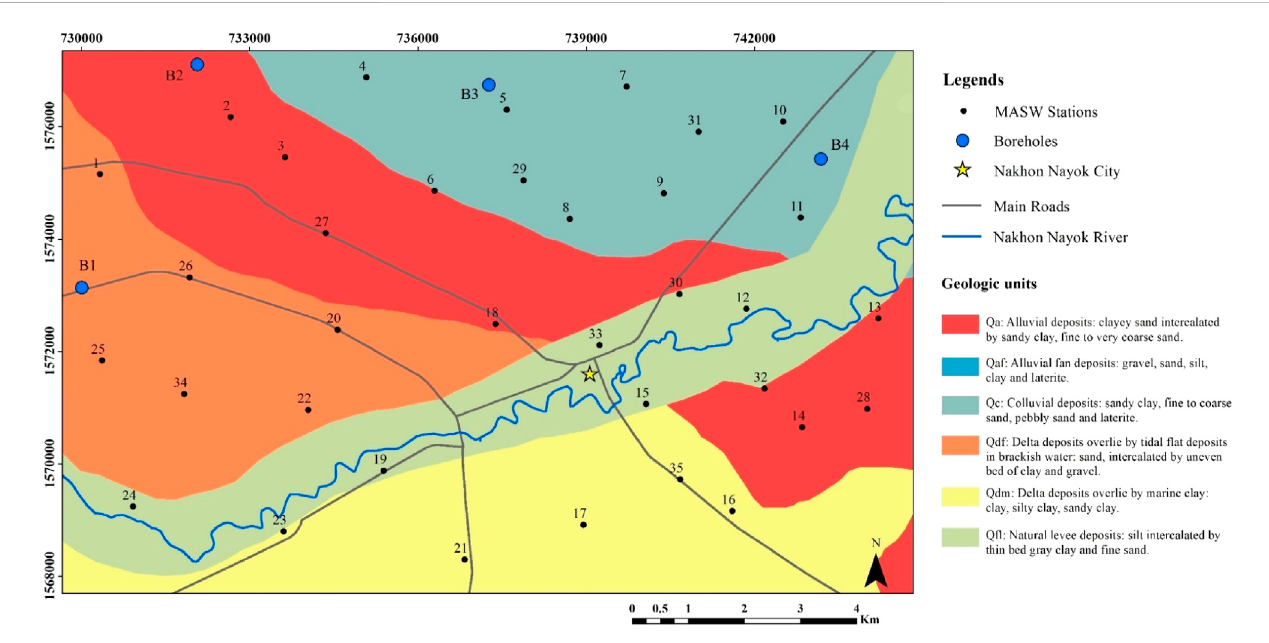
Sur fi cial geological map of the study area, the MASW test sites, and locations of the boreholes.